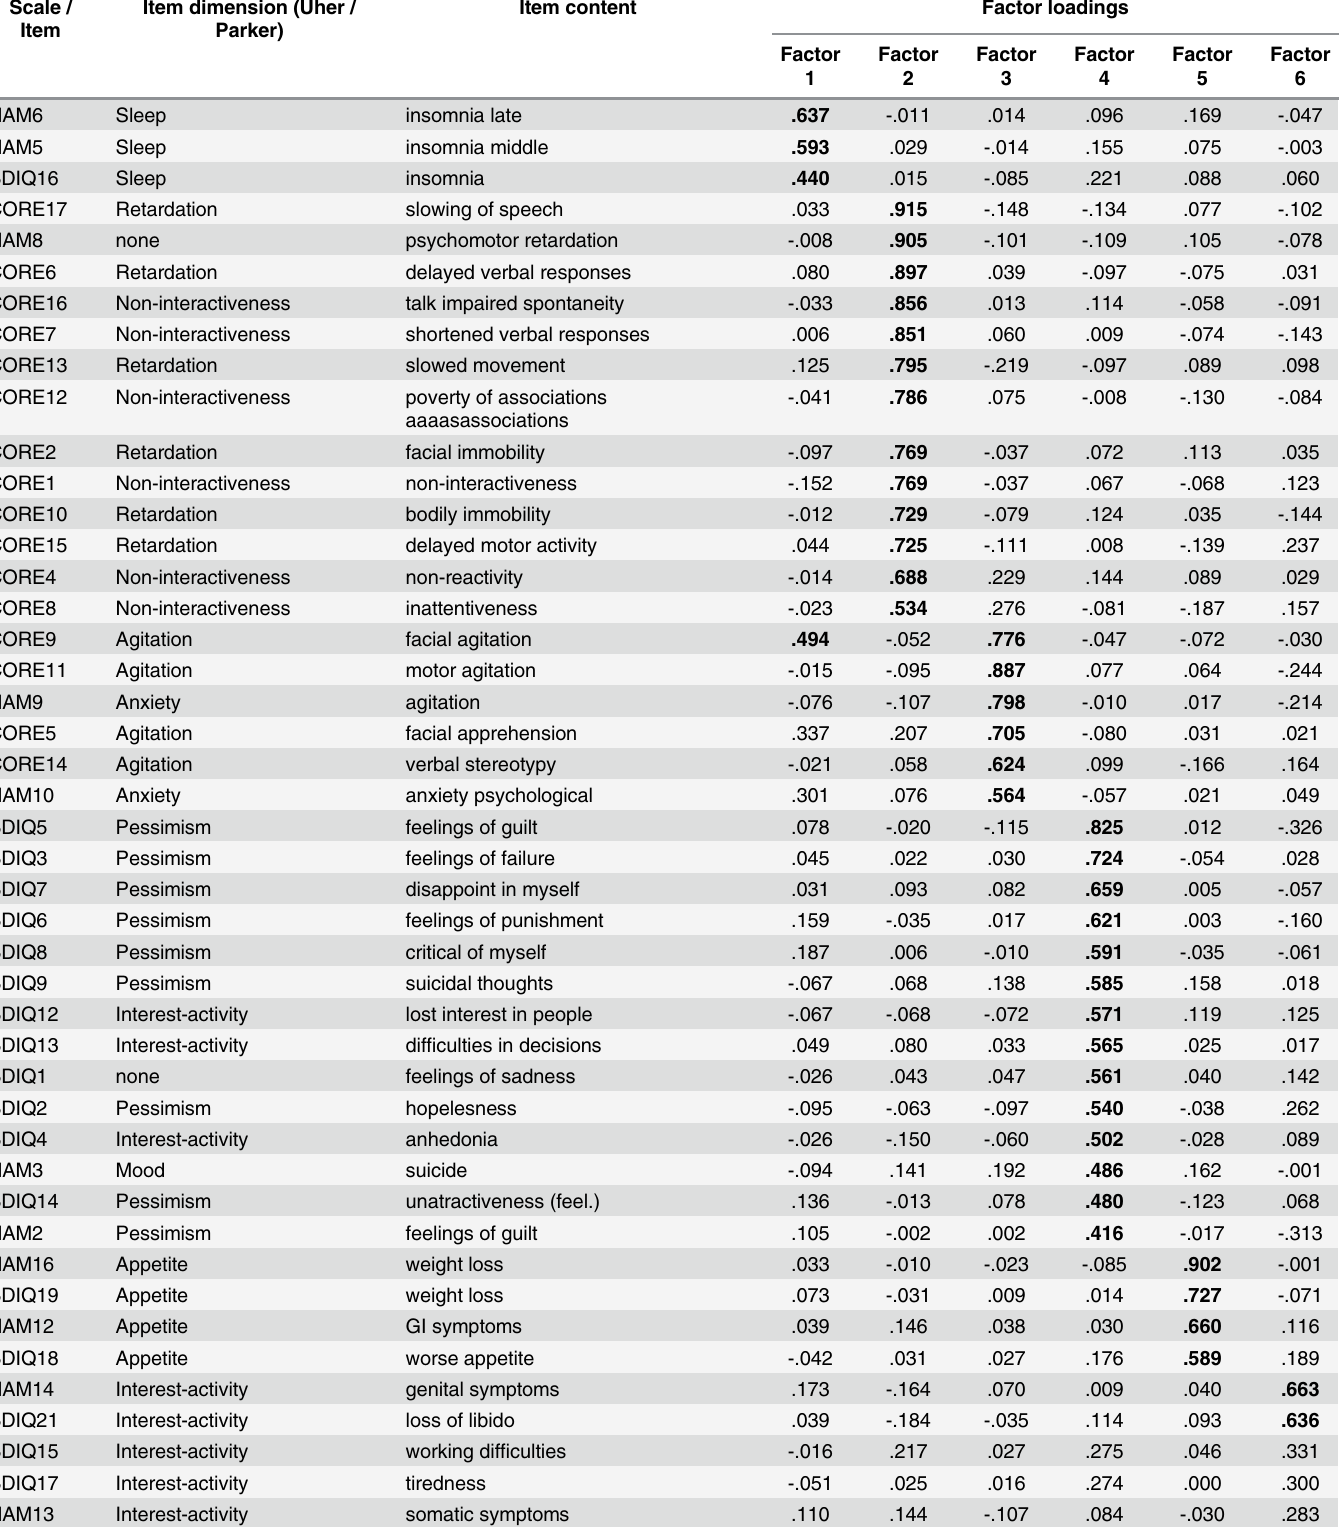
Table 2. Exploratory Factor Analysis six-factor solution. Scale /